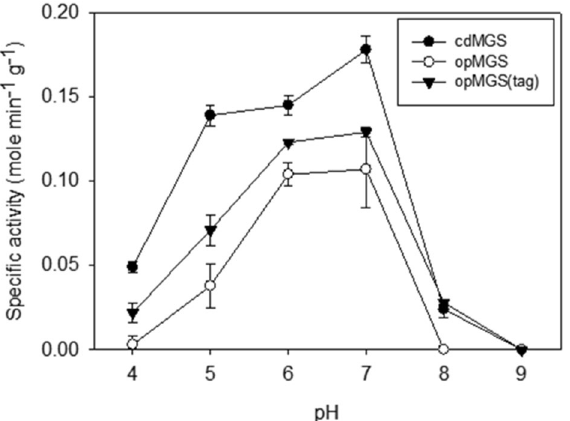
Figure 2. pH optima for the purified MGSs. Each value and error bar represents the mean and the standard deviation of at least three independent trials, respectively.